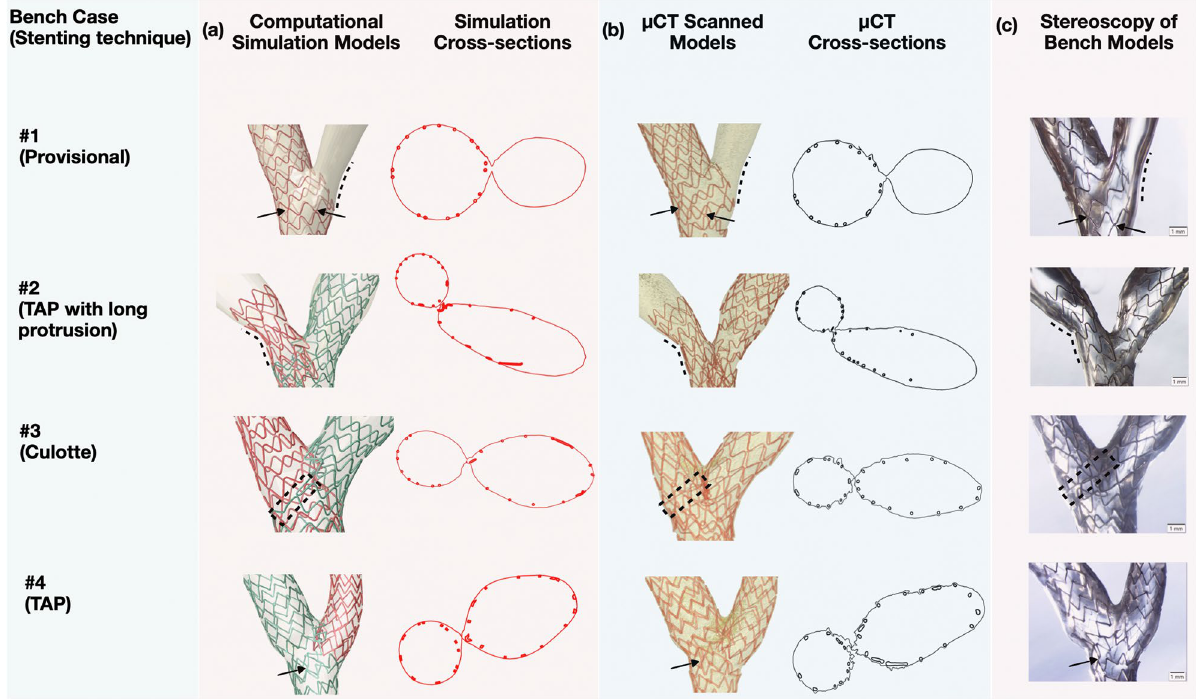
Figure 4. Qualitative comparison of computational stenting simulation of bench bifurcation models at the carina. Computational stenting ( a ) compared with bench stenting imaged by μCT ( b ) and stereoscopy ( c ) at the anatomically sensitive site of the carina. Simulation cross-sections (red) compared with the cross-sections from the µCT reconstructed model (black) showing similarity in the lumen shape at carina. In case #1 note the similarity of two stent links (black arrows), and the vessel curvature (black dotted line) in simulation and µCT and stereoscopic image. In case #2, note the similarity in vessel curvature (black dotted line). In case #3, note the very similar link position and shape (black dotted rectangle) at the bifurcation. In case #4, note the similarity in the position of stent link (black arrow); TAP T and protrusion, µCT micro-computed